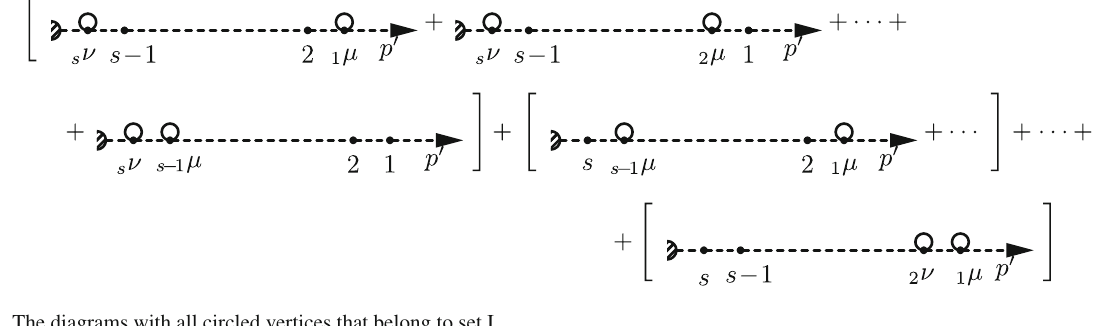
Fig. 6 The diagrams with all circled vertices that belong to set